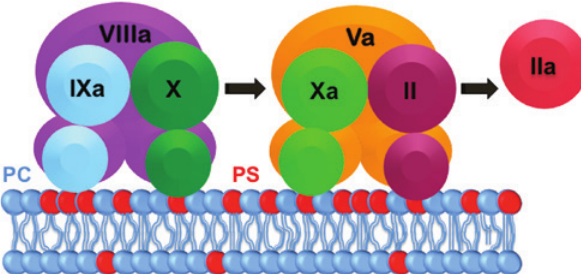
Figure 2: The propagation phase of coagulation. The intrinsic tenase complex between the co-factor, factor VIIIa (VIIIa), and the serine protease, factor IXa (IXa), is highly homologous to the